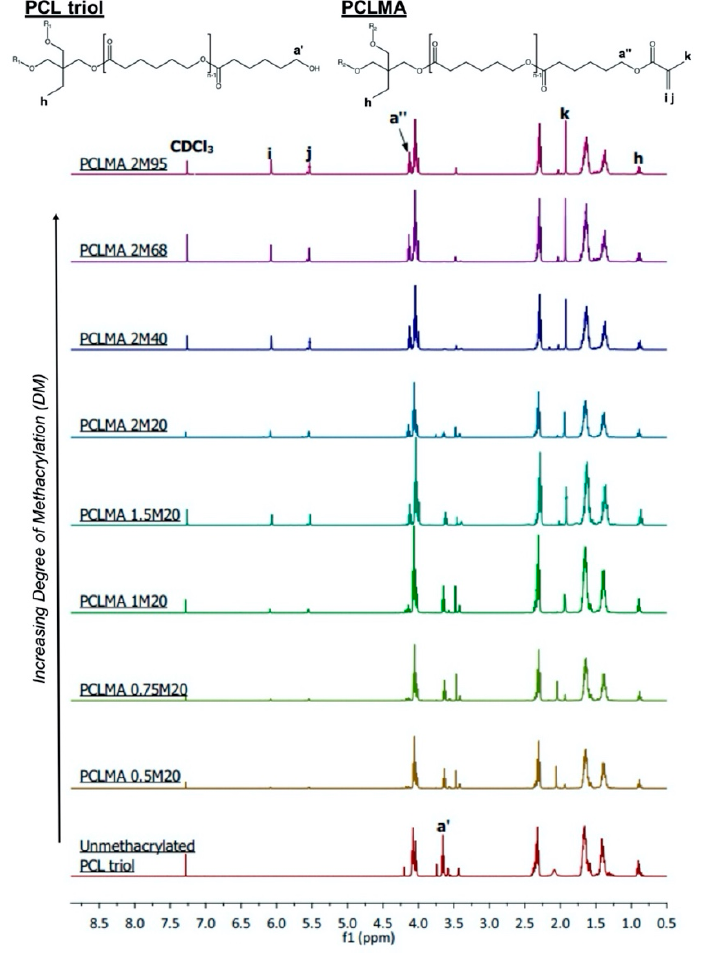
Figure 1. Proton NMR spectra of unmethacrylated and methacrylated PCL triol. The PCL triol and PCLMA molecule diagrams are displayed (top) with the hydrogen environments labelled ( 𝑎′ , 𝑎′′ and ℎ ‐ 𝑘 ) corresponding to the relevant peaks in the NMR spectra used to determine degree of methacrylation. 𝑎′′ , 𝑖 , 𝑗 and 𝑘 are present only in methacrylated PCL, so the size of these peaks in ‐ creases with increasing DM.